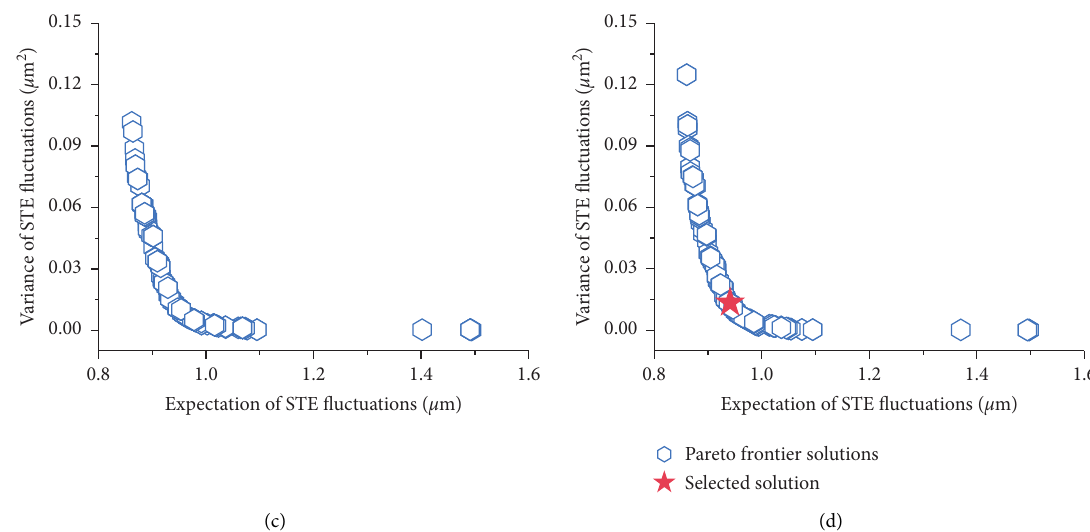
Figure 15: Evolution process of the obtained results for combined tooth surface modification parameters. (a) The 5th generation. (b) The 30th generation. (c) The 100th generation. (d) The 200th generation.